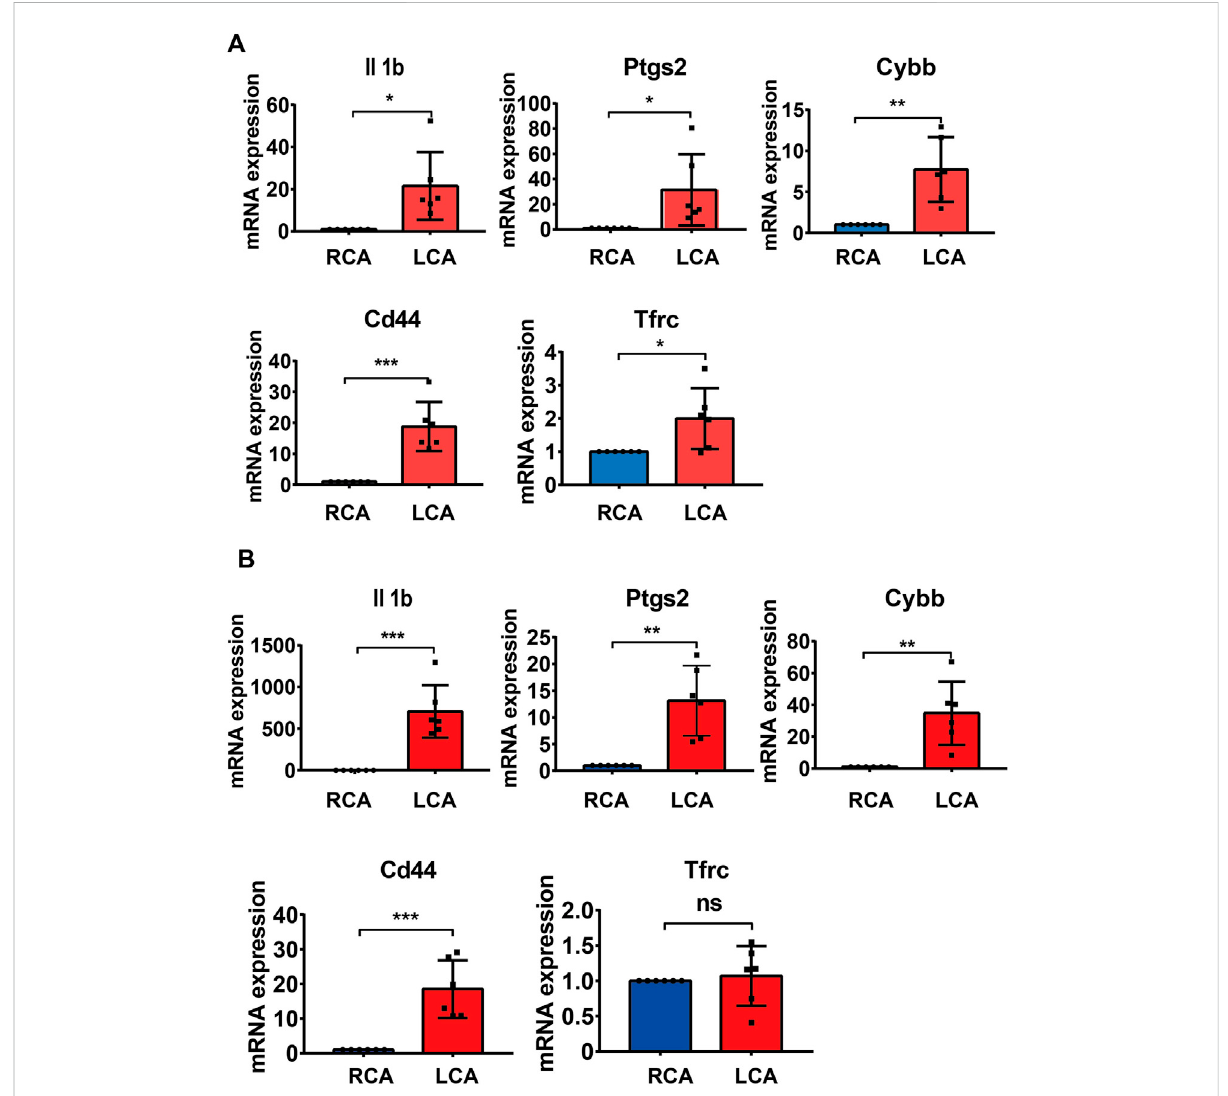
FIGURE 6 Validation ofmRNA levels. (A) ThemRNA levels of Il1b, Ptgs2,Cybb, and Tfrc 2days after ligation intherightcarotid artery(RCA)and leftcarotid artery (LCA) groups in mice. (B) The mRNA levels of Il1b, Ptgs2, Cybb, Cd44, and Tfrc 14 days after ligation in the RCA and LCA groups in mice. All values have been standardized using the expression levels of GAPDH. A two-tailed unpaired Student ’ s t-test was used to compare two groups. Data are expressed as the means ± SD, n = 6, * p < 0.05; ** p < 0.01; *** p < 0.001; **** p <